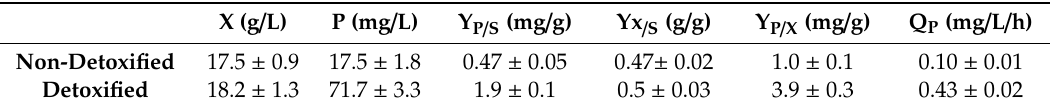
Table 3. Biomass and astaxanthin output following P . rhodozyma cultivation in non-detoxified and detoxified stillage media after ethanol removal.